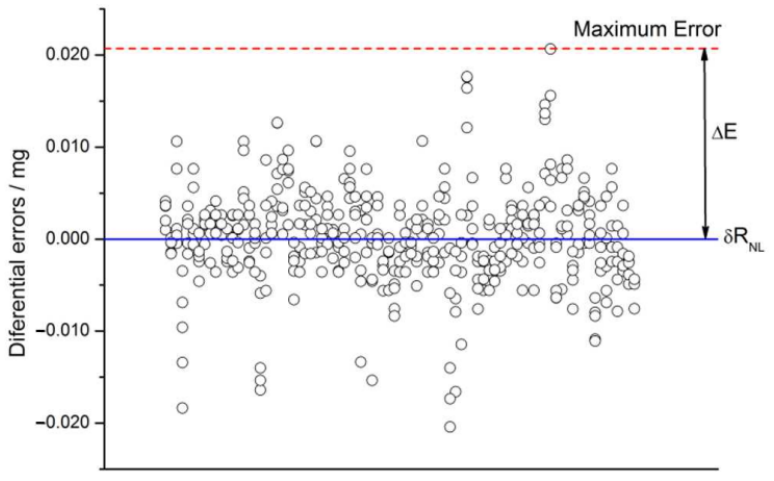
Figure 12. Individual differential calibration errors. Blue line is the mean value.